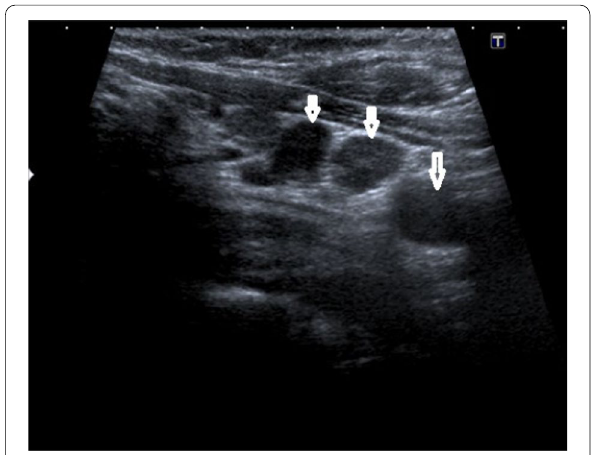
Fig. 5 Female hypothyroid patient, 34-years old. Longitudinal view gray-scale U/S of lower anterior neck region in shows enlarged para-tracheal lymph nodes with globular shape & lost hilum